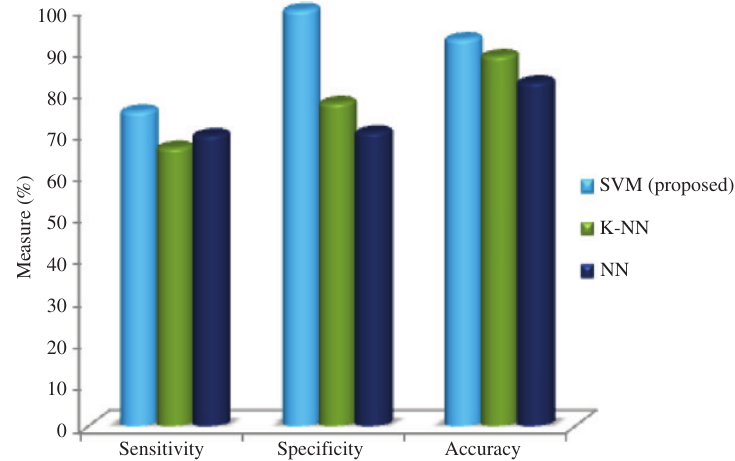
Figure 4: Comparative Analysis of the Different